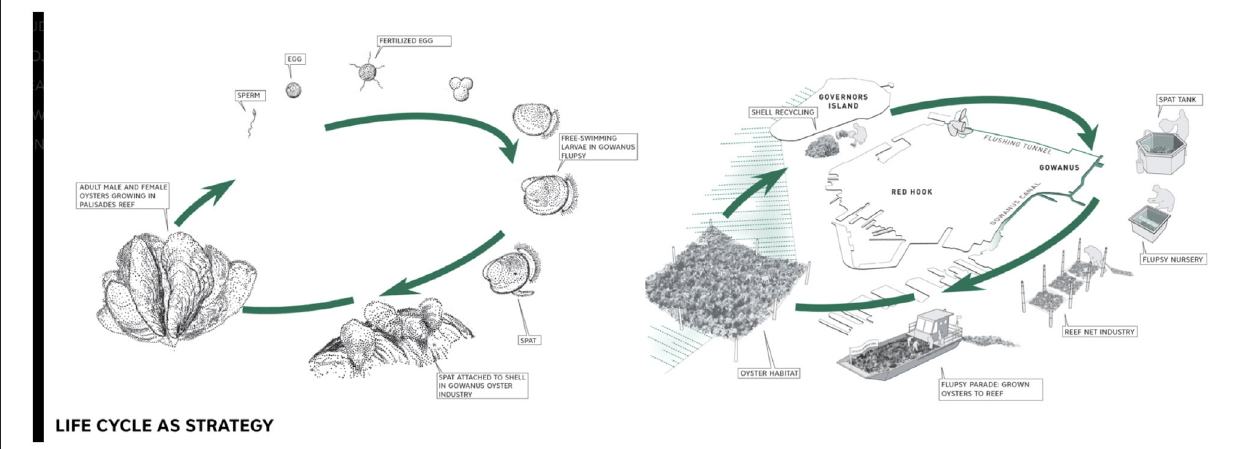
FIGURE 6 | The proposed design for Oyster-Tecture is an example of Ecological Theory Applied through Design. Illustration courtesy SCAPE/Kate Orff, developed for the Musem of Modern Art’s ‘Rising Currents’ exhibit (2009).